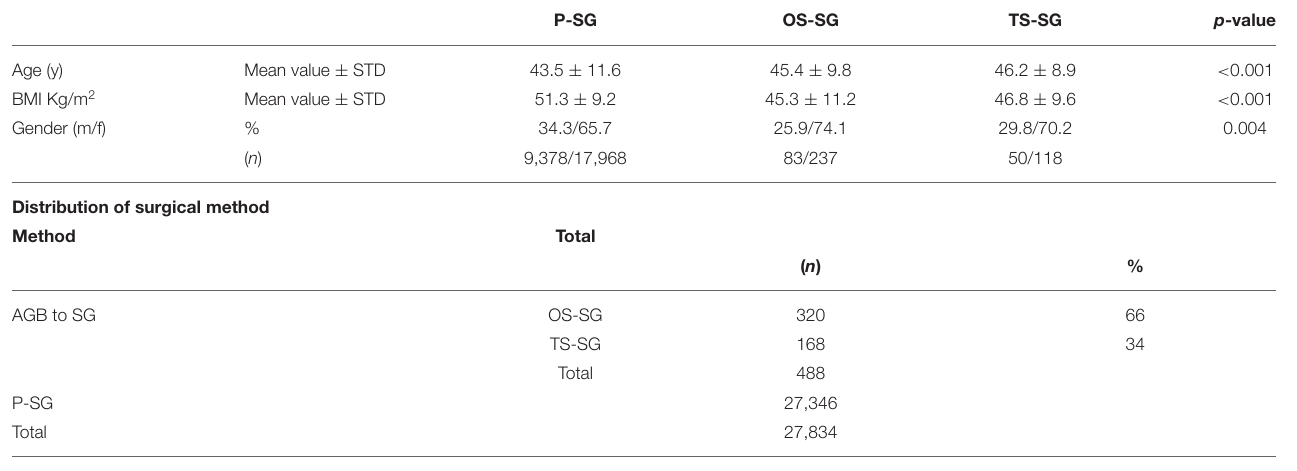
TABLE 1 | Distribution of patients according to demographic variables and surgical